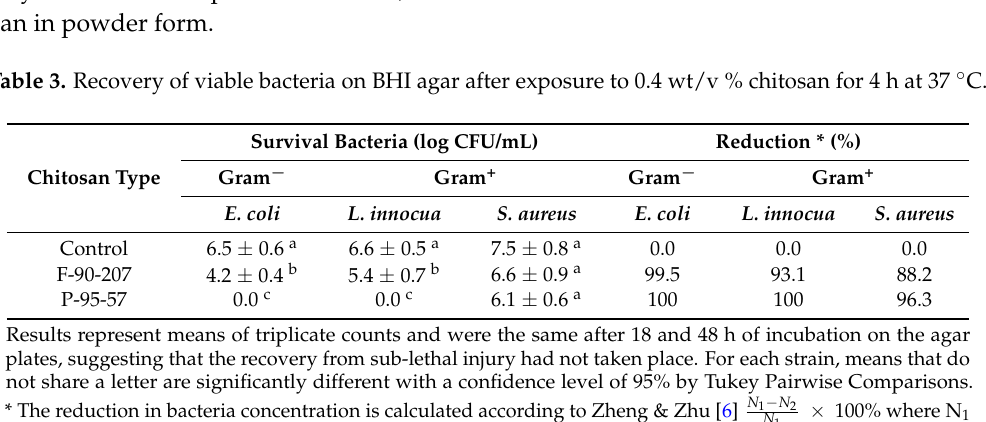
Table 3. Recovery of viable bacteria on BHI agar after exposure to 0.4 wt/v % chitosan for 4 h at 37 ◦ C.